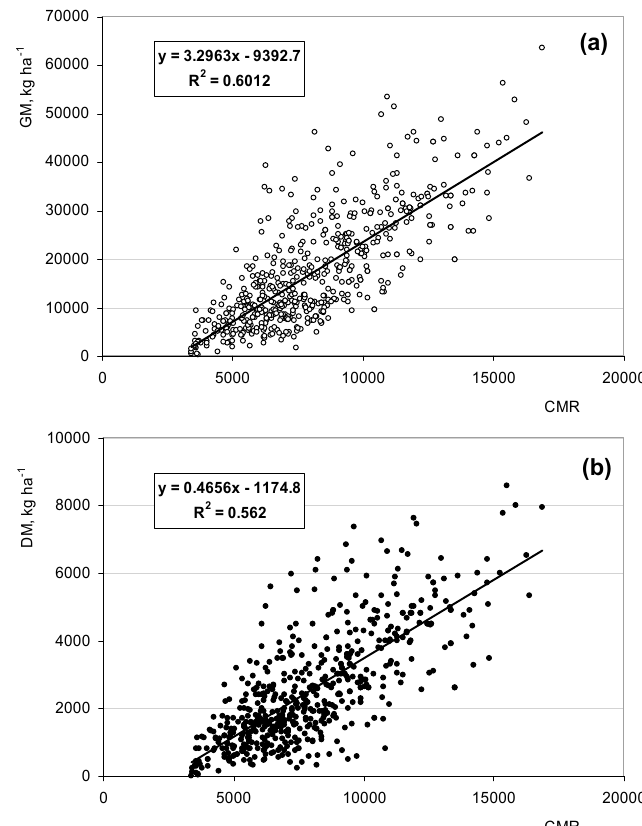
Figure 7. Linear regression equations between Grassmaster II measurements (CMR) and pasture productivity for pasture moisture content (PMC) > 80%: ( a ) green matter (GM) versus CMR; ( b ) dry matter (DM) versus CMR.